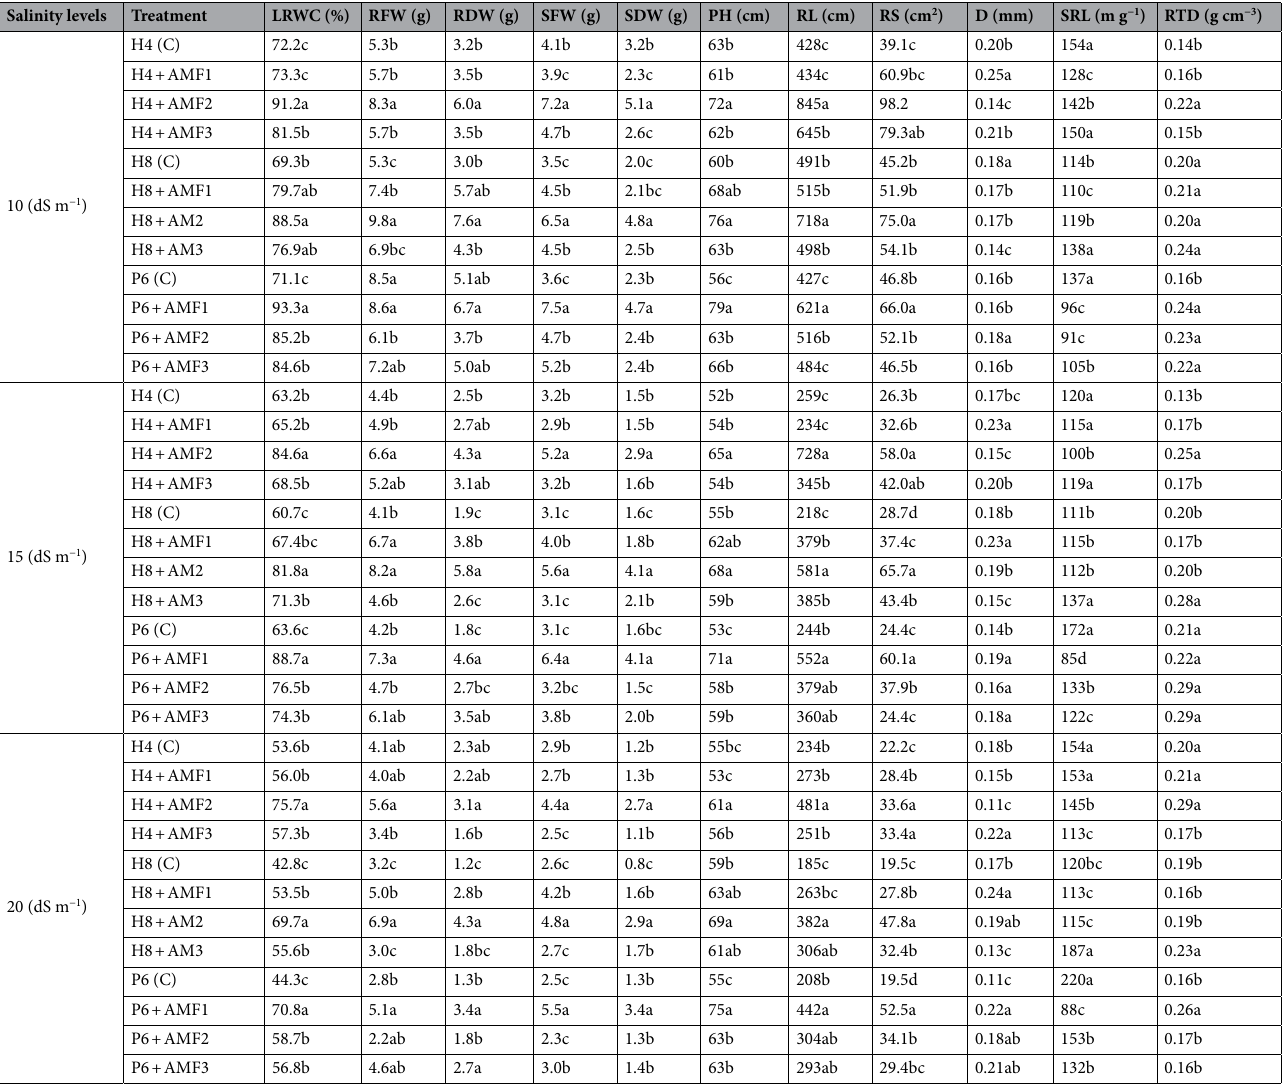
Table 3. Influence of different salinity levels on leaf relative water content (LRWC), root fresh weight (RFW), root dry weight (RDW), shoot fresh weight (SFW), shoot dry weight (SDW), plant height (PH), root length